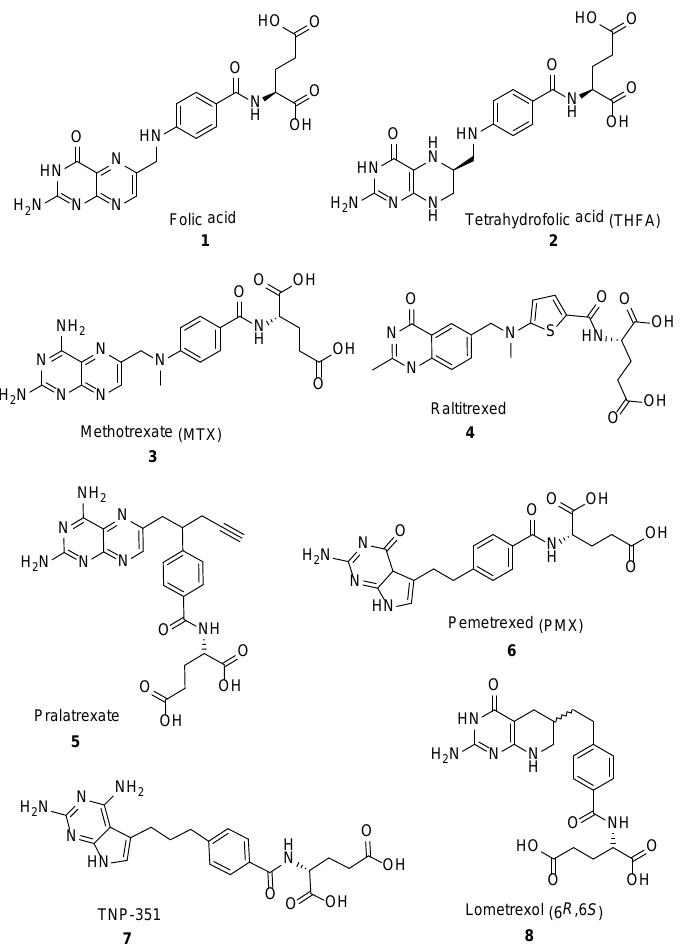
Figure 1. Structure of folic acid ( 1 ) and tetrahydrofolic acid (THFA) ( 2 ) and their antimetabolites. Once it became clear that methotrexate directly inhibits not only dihydrofolate re- ductase but also the enzymes for the synthesis of purines and thymidylate synthase, the coenzymes of which are reduced folates, a search commenced for folic acid antagonists that selectively inhibit these enzymes. By replacing the N-5, N-8 and N-10 atoms and modifying the side chains of the methotrexate molecule, it was possible to synthesize drugs that retain their inherent ability to form stable polyglutamates inside the cell, but better penetrate the tumor [15], such as the following: raltitrexed, a thymidylate